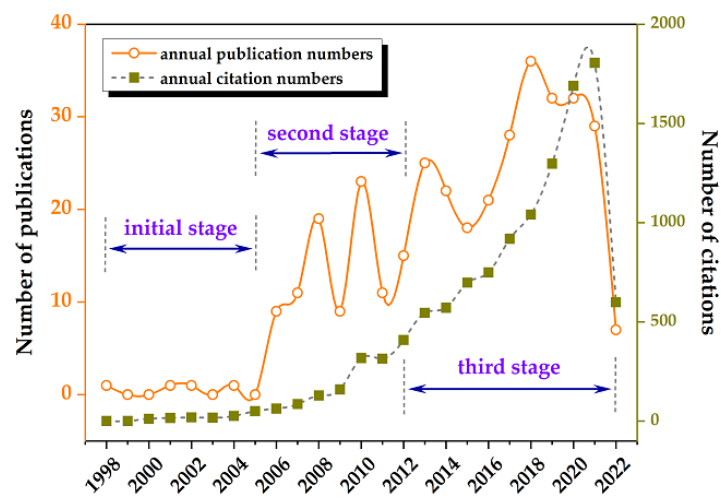
Figure 1. The number of publications and citations.